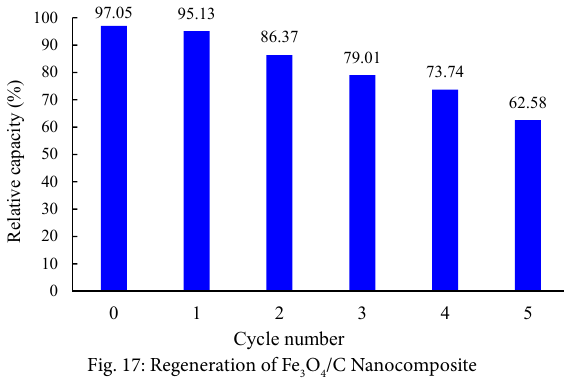
Fig. 17: Regeneration of Fe Table 4: Kinetic data for the MB adsorption on Fe 3 O 4 /C nanomaterials Table 4: Kinetic data for the MB adsorption on Fe